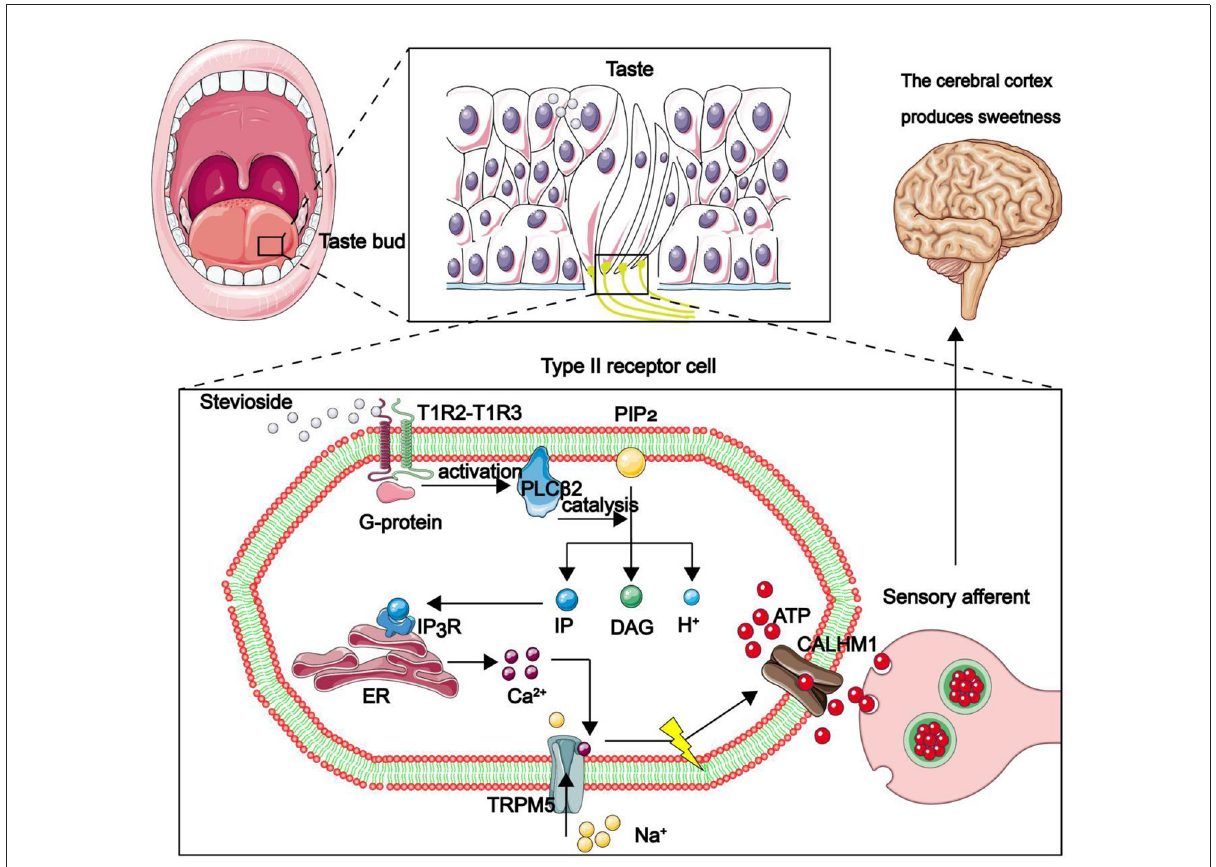
FIGURE1 Mechanism through which the human body feels sweetness. The front end of the tongue is the main area for sweet taste. Taste pores at the front of taste buds are mainly composed of type II taste receptor cells (TRCs), while the calcium homeostasis regulatory protein 1 (CALHM1) gene is specifically expressed only in type II taste sensing cells. The sweet substance binds to the sweet receptor T1R2–T1R3 dimer on TRCs, thereby activating the coupled G protein, then the phospholipase C β 2 (PLC β 2) is deactivated. PLC β 2 acts as a catalyst, participating in the decomposition of phosphatidylinositol diphosphate (PIP2) to produce inositol triphosphate (IP3), diacylglycerol (DAG) and H + . IP3 combines with inositol triphosphate receptor (IP3R) in the endoplasmic reticulum to promote release of Ca 2 + in the endoplasmic reticulum. Ca 2 + binds to TRPM5. The channel is opened to allow Na + to flow in, depolarize the membrane potential, promote the opening of CALHM1 channel, and the adenosine-triphosphate (ATP) outflow as a neurotransmitter transmits information to the synapse of taste afferent nerve. Finally, sweetness is produced in the cerebral